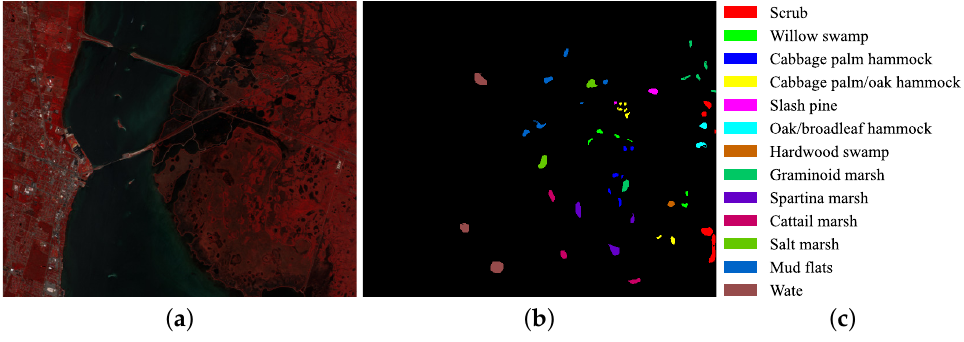
Figure 6. False color image and ground truth image of the KSC dataset. ( a ) False color image. ( b ) Ground truth image. ( c ) Color coding for each